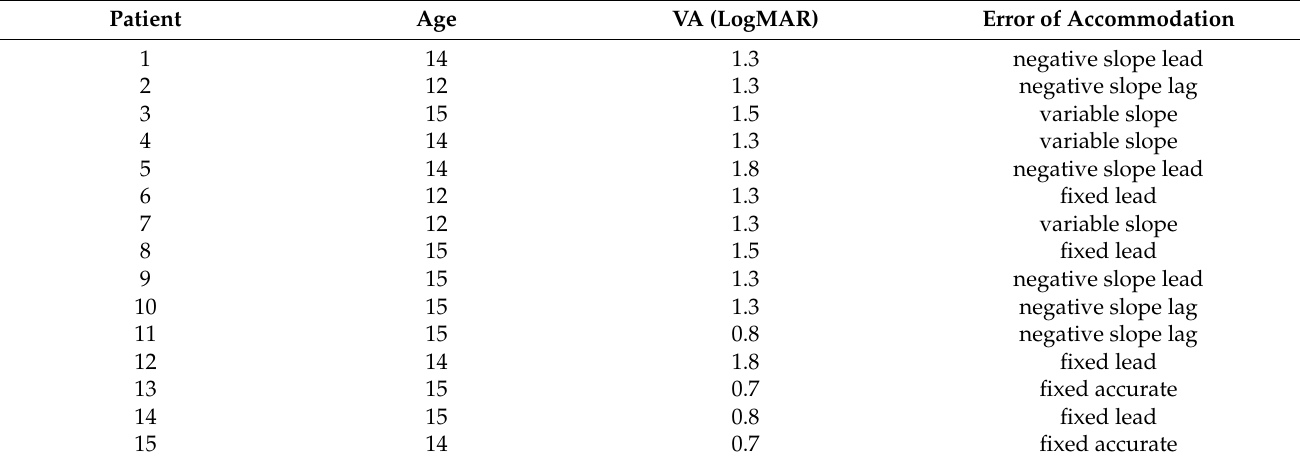
Figure 3. A sample of accommodative responses observed in this study, those are patients’ numbers 4, 5, 6, 9, and 15 that demonstrate the five subtypes founds at the three accommodative demands 2, 3, and 5 Diopters. The average accommodative responses for visual impairment group (AV.VI group) and for participants with healthy vision (AV.HP group) was also illustrated. Table 2. The age, visual acuity, and associated accommodative response subtype for each participant in the visual impairment group.